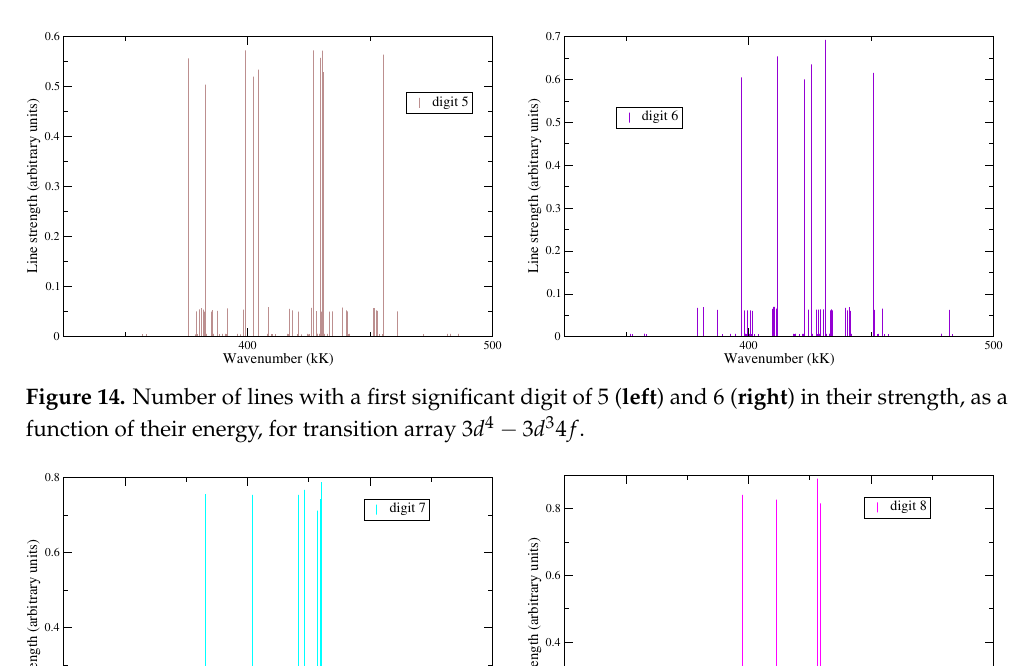
Figure 15. Number of lines with a first significant digit of 7 ( left ) and 8 ( right ) in their strength, as a function of their energy, for transition array 3 d 4